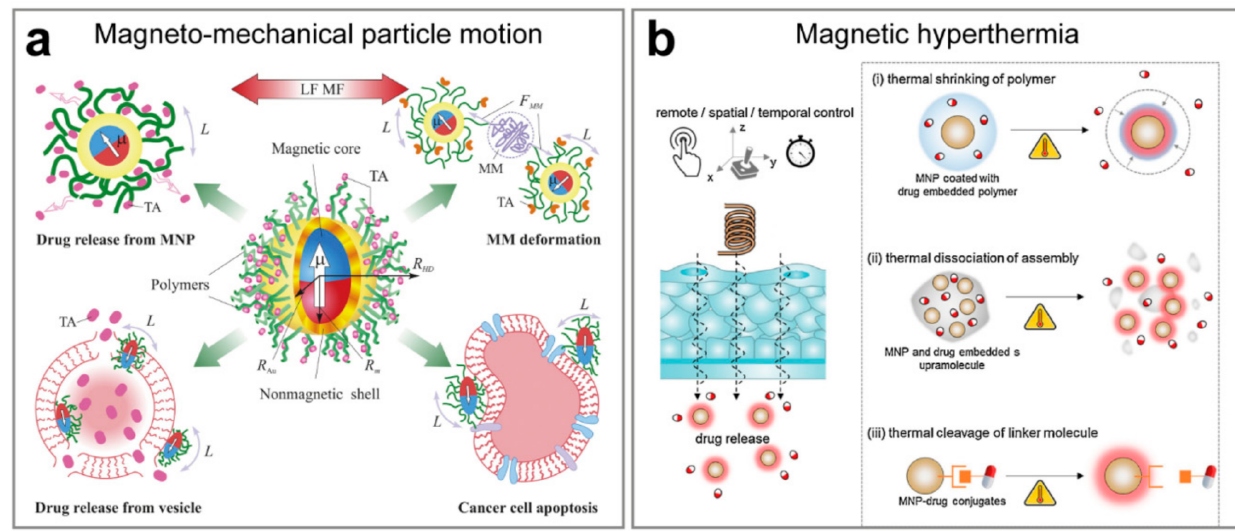
Figure 3. Drug release is triggered by an alternating magnetic field. ( a ) Schematic presentation of currently explored directions in nanomedicine and drug delivery that exploit magneto-mechanical actuation of functionalized MNPs in a low-frequency magnetic field. Abbreviations correspond to a low-frequency AMF (LF MF), therapeutic agent (TA), the magnetic moment of ( µ ), the torque applied to MNP (L), the macromolecule (e.g., enzyme) attached to MNP (MM), and the magneto-mechanical force causing macromolecule deformation ( F MM ). A schematic of functionalized MNP is presented having a superparamagnetic core of a radius R m , a solid shell (e.g., gold) of a radius R Au , and water-soluble polymeric corona. The hydrodynamic radius of the functionalized MNP is R HD . Reproduced with permission from [112]. Copyright 2015, Elsevier B.V. ( b ) Magnetothermally triggered drug delivery systems. Due to the remote and spatiotemporal controllability of AMF, drugs can be released and delivered at a target at the desired time. Various types of drug release systems are possible, based on (i) shrinkage of thermoresponsive polymers, (ii) thermal dissociation of self-assembled nanostructures, and (iii) thermal cleavage of temperature-sensitive linker molecules. Reproduced with permission from [111]. Copyright 2017, Elsevier